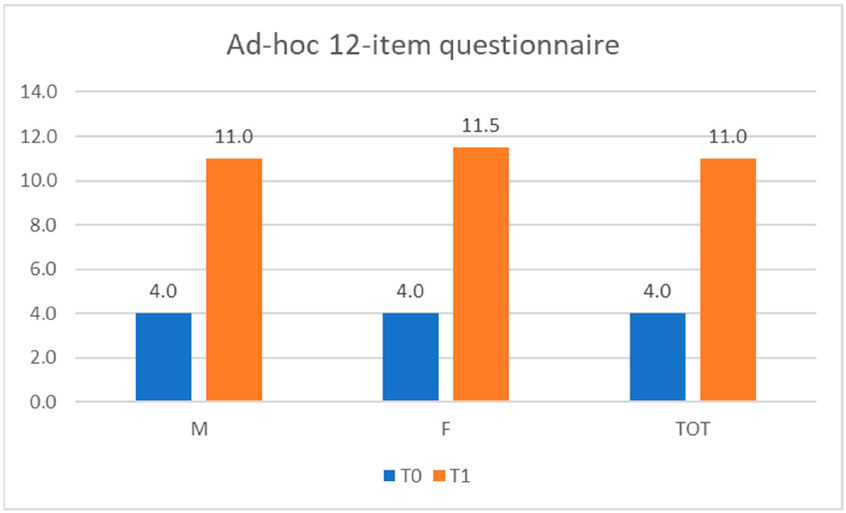
Figure 6. Ad hoc 12-item questionnaire scores. M = male; F = female; TOT = total.